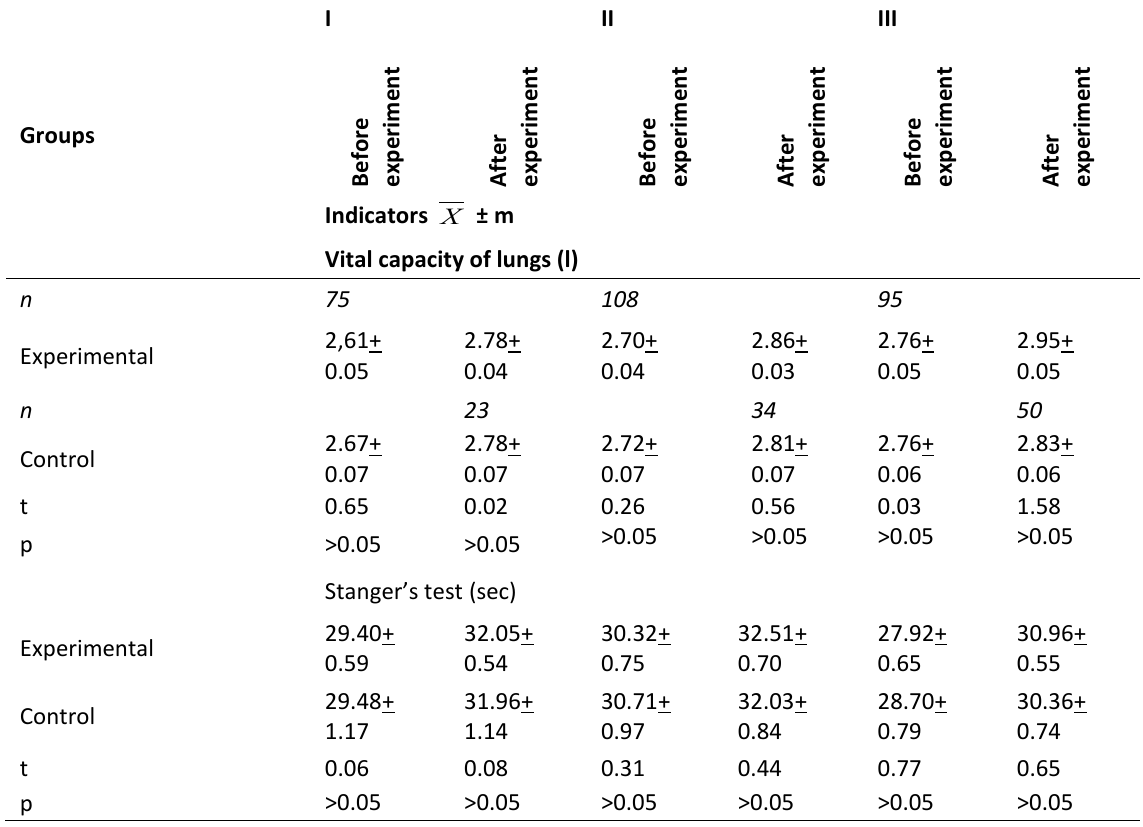
Table 2. Indicators of respiratory system’s functional state of experimental and control groups’ girl students before and after